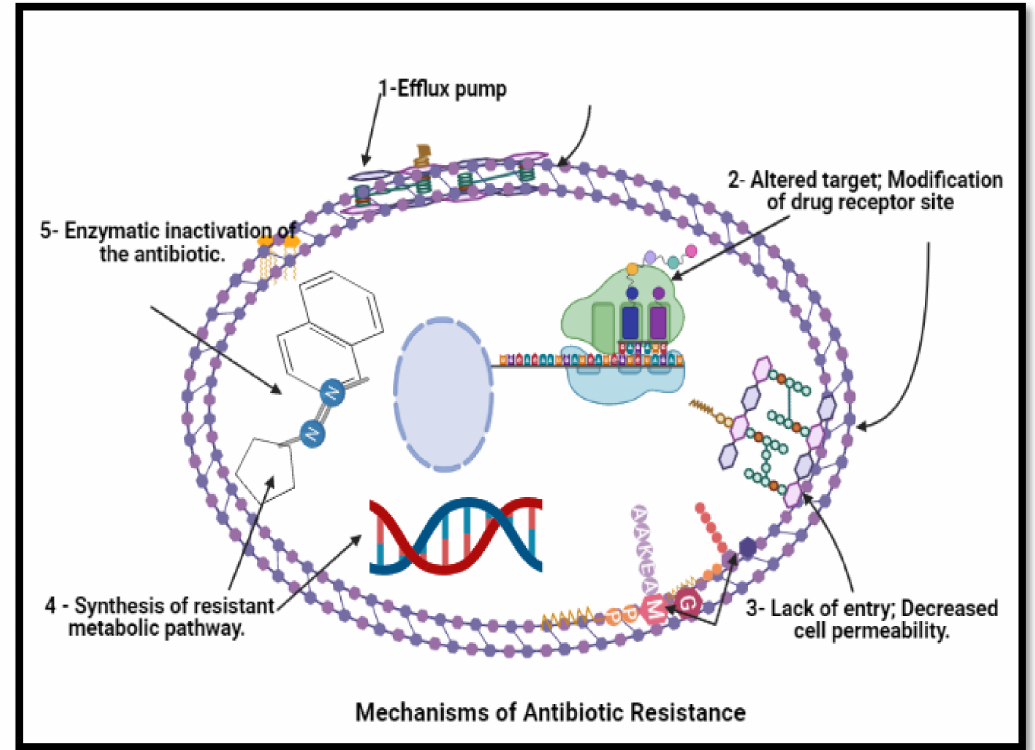
Figure 6. Mechanism of anti-bacterial resistance to avoid killing by antimicrobial molecules. N.B.: BioRender was used to draw these scientific